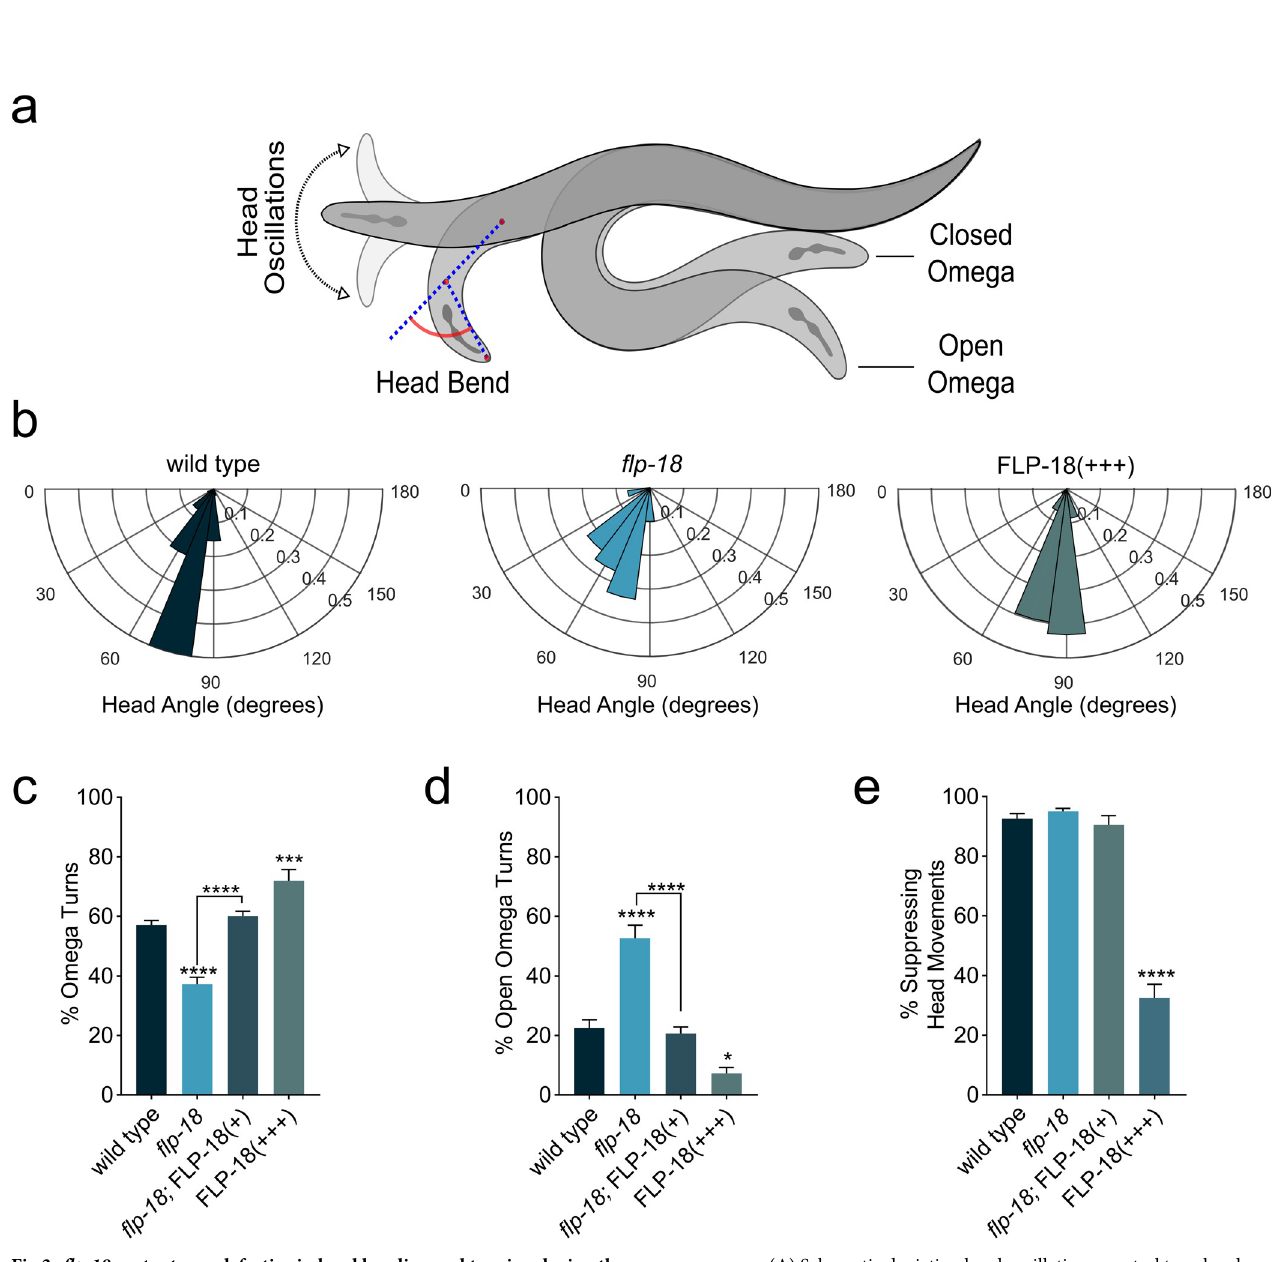
Fig 3. flp-18 mutants are defective in head bending and turning during the escape response. (A) Schematic depicting head oscillations, ventral turn head angle and open vs closed omega turns. (B) Angle of ventral head bend following touch induced reversal of animals that make omega turns (probability histogram with a bin size of 15˚). Each concentric circle represents a probability of 0.1. (C-D) Quantification of omega turning behavior. (C) Percentage of animals that execute omega turns in response to gentle anterior touch. (D) Fraction of open omega turns out of total omega turns. (E) Quantification of the percentage of animals suppressing head oscillations upon gentle anterior touch. Mean ± SEM. significance was calculated using ANOVA with S ˇ ida´k’s multiple comparison correction (P < 0.05 = � , P < 0.0005 = ��� , P < 0.0001 = ���� ). Sample sizes: Ventral head bend measurement (B) (n = # of animals), wild type (n = 52), flp-18 (n = 30), FLP-18(+++) (n = 58). Suppression of head movement and omega quantification (C-E) (n = # of experiments, 20 worms per experiment) wild type (n = 17), flp-18 (n = 16), flp-18; FLP-18(+) (n = 9), FLP-18(+++) (n =